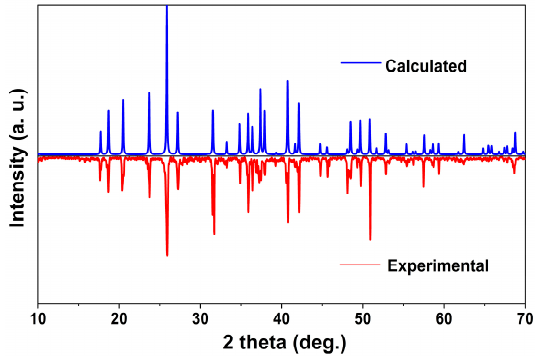
Figure 4. Powder X-ray diffraction (XRD) patterns of LiSm 3 SiS 7 .